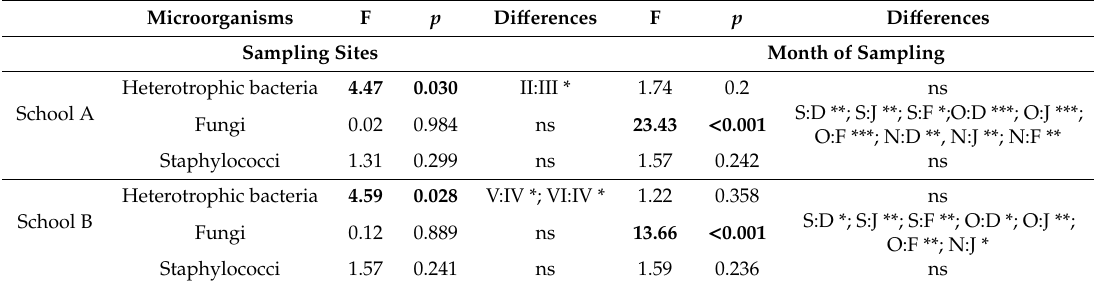
Table3. Statisticaldifferencesinmicrobialconcentrationsdependingonasamplingsiteandsamplingmonth.